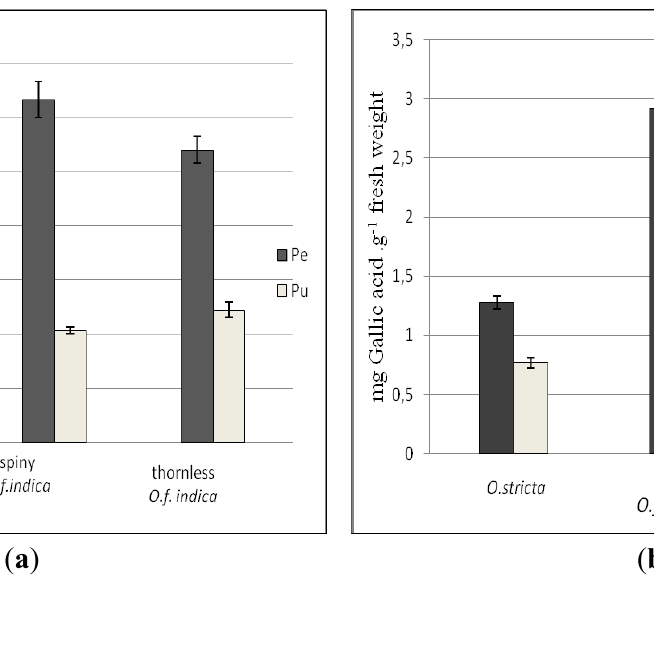
Figure 1. Total phenolic content of peel (Pe) and pulp (Pu) of three Tunisian Opuntia ( O .) forms. Results are expressed as mg rutin equivalents g −1 fresh weight ( a ) and as mg GA equivalents g −1 fresh weight ( b ) (mean ± SD, n = 3). Means of triplicates pulp and pulp indicate no significant difference (level of significance p < 0.05) between the three Tunisian Opuntia